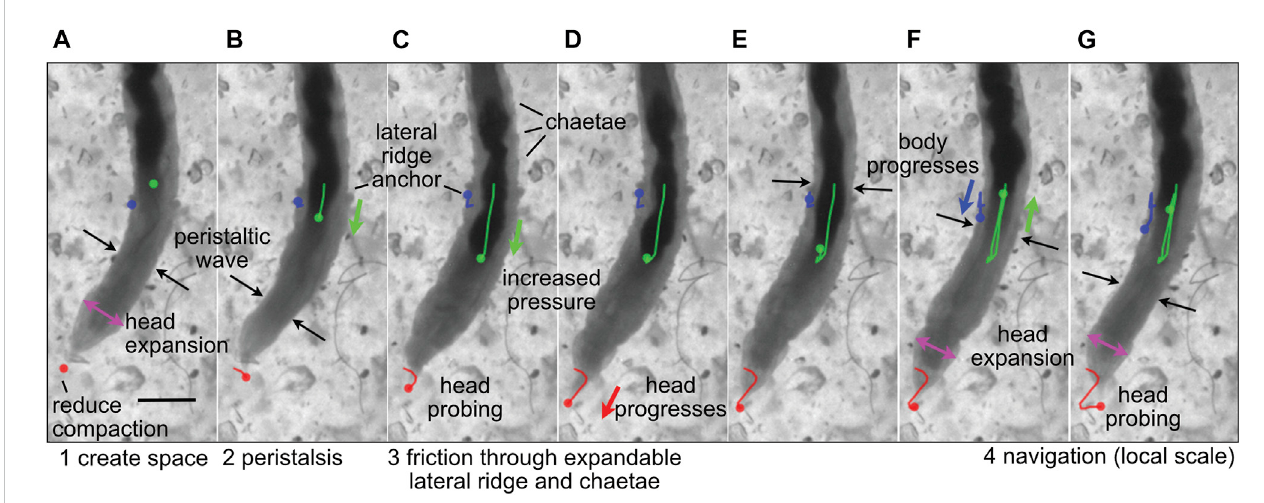
FIGURE 2 Image sequence of the polychaete worm, Thoracophelia mucronata, burrowing in cryolite grains, a transparent sand analog. (A) The worm expands its head (magenta arrows), reducing compaction of sand in front of the head (tip marked with red dot), as (A,B) a wave of contraction (black arrows) moves anteriorly in direct peristalsis. (B – D) The worm anchors its posterior region by expanding balloon-like appendages on both sides of the 11th segment, called lateralridges(blue), and extending hairscalled chaetae from othersegmentsto increasefriction (C,D) Segments posteriorofthelateralridgecontractto push the gut (darker color, marked with green) forward, increasing pressure in the anterior region of the worm to push the head forward. The tip of the head probes (C,G) to fi nd theeasiest pathforwardthrough thesandgrains.Colored dots show thelocation inthecurrent frameof thetipofthehead (red),anterior point inthelateral ridge(blue) and anterior point inthegut that canbeseen through thebody wall(green),and lines in (B – G) show thetracked progression of that position from image (A) . Modi fi ed from Figure 4 of Dorgan (2018) with